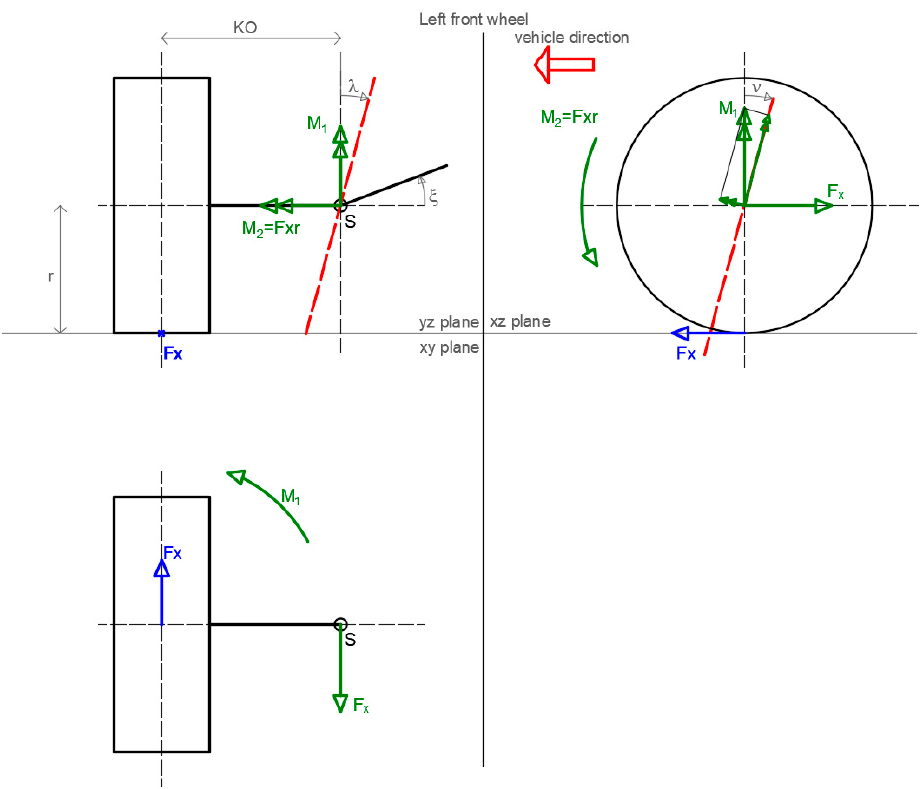
Figure 7. Case 4: kingpin and caster angles > 0.